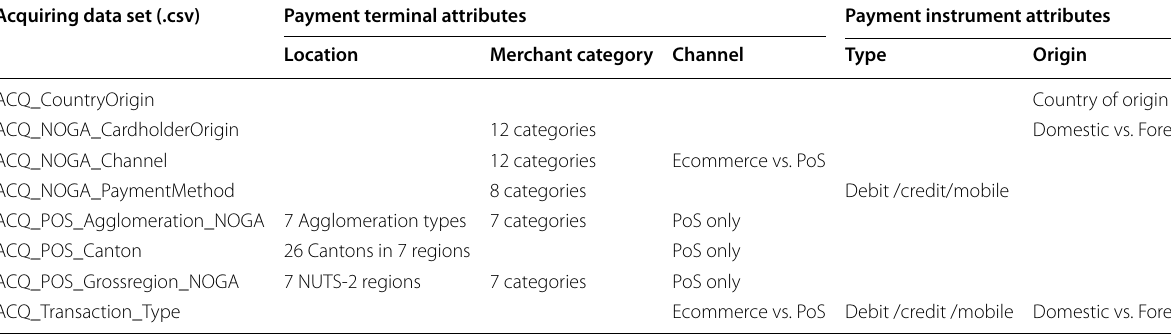
Table 2 Data sets based on acquiring data Acquiring data set (.csv)